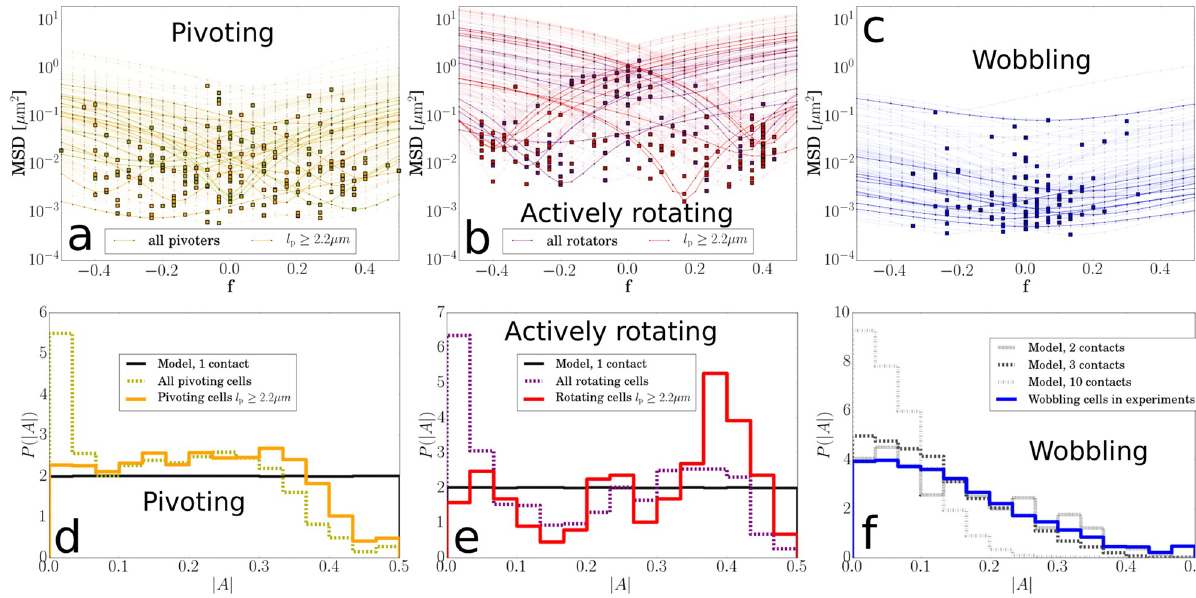
Fig 6. Anchoring points for different types of adhering. (a-c) MSD along the length axis for trajectories of 200 pivoters, 200 rotators, and 100 wobblers. For pivoters and rotators, data is shown for 100 cells of any length and for 100 cells with a projected length l p � 2.2 μ m. For clarity, all but 10 lines are ghosted for each set of examples. For each trajectory, the minimum in MSD denotes the anchoring point. (d-f) The distribution of anchoring points along the length axis A 2 [ − 0.5, 0.5]. The absolute value | A | is used because the two poles are taken to be indistinguishable. The histograms are constructed from trajectories of 9404 pivoters (d), 700 rotators (e) and 7415 wobblers (f).